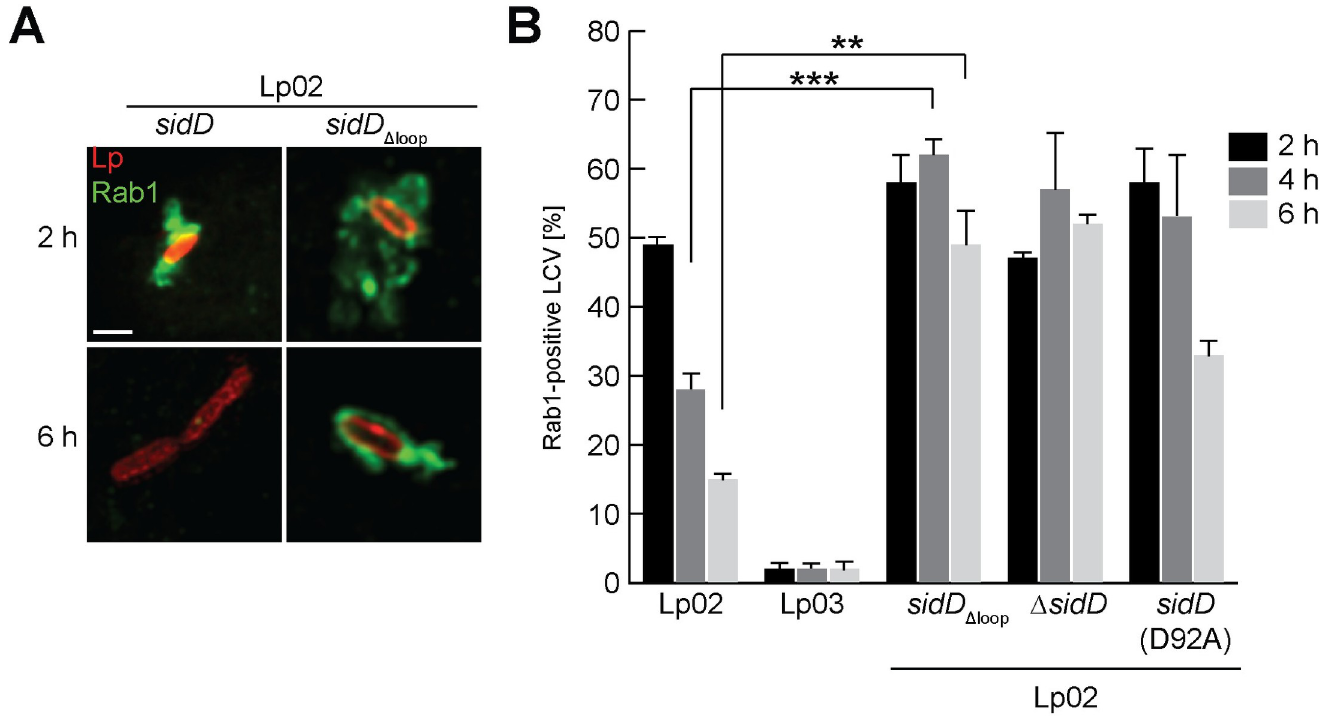
Fig 7. Membrane association of SidD is critical for Rab1 deAMPylation. (A) Rab1 dynamics on the LCV surface. Bone marrow macrophages challenged with the indicated L . pneumophila strains were chemically fixed at the indicated time points. Rab1 was detected by indirect immunolabeling using a Rab1B-specific antibody followed by secondary Alexa Fluor 488-conjugated antibody. L . pneumophila was stained with anti- Legionella -specific antibody and TexRed-conjugated secondary antibody. Cells were examined by confocal microscopy showing L . pneumophila in red and Rab1 in green. Scale bar, 1 μ m. (B) Quantification of LCVs decorated with Rab1 analyzed under (A). At least 100 LCVs were counted per sample to determine the percentage of LCVs decorated with Rab1. The graph shows the average of three independent replications. ��� P < 0.001, �� P < 0.01.